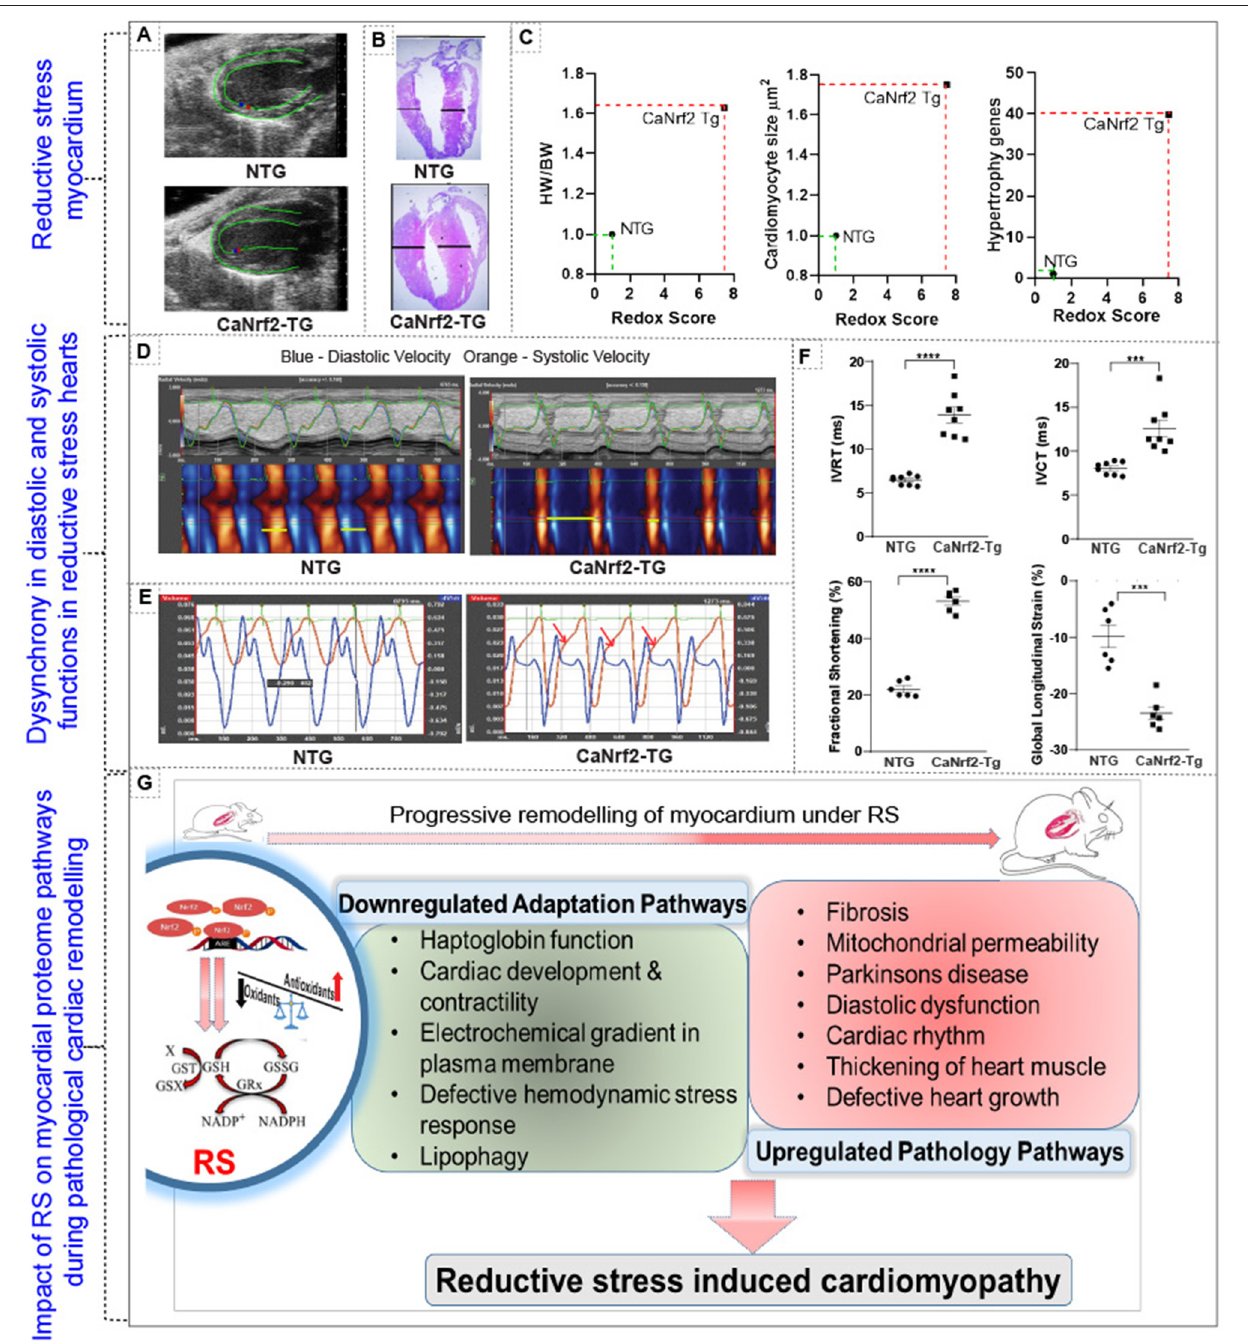
FIGURE 4 | Impact of reductive stress on myocardial proteome signaling and pathological structural and functional remodeling. (A) Speckle tracking tracing showing deformation in the myocardial structure at longitudinal plane (PSLAX axis). (B) Morphology of hearts from autopsy of TG and NTg heart. (C,D) Correlating the impact of RS on structural remodeling at cellular (i.e. cardiomyocytes cell size), organ (i.e. heart/body weight ratio) and molecular (i.e. hypertrophy markers) level. (D) Cardiac function by speckle tracking echo analysis for wall motion- diastolic and systolic velocity, and (E) MVE and MVA waves and (F) other parameters fractional shortening, global longitudinal strain, isovolumic relaxation time (IVRT) and isovolumic contraction time (IVCT). (G) Schematic representation of altered proteome profiles/pathways and their impact on cardiac pathology during chronic RS. *** p < 0.001; **** p < 0.0001. in TG/RS hearts, which is a typical pattern seen in myocardial regulatory or pathological check points in these hearts, which infarction or mechanical stress that leads to cardiac remodeling needs further investigation (37, 38). Speckle-tracking based (39, strain analysis of longitudinal global strain curves are altered